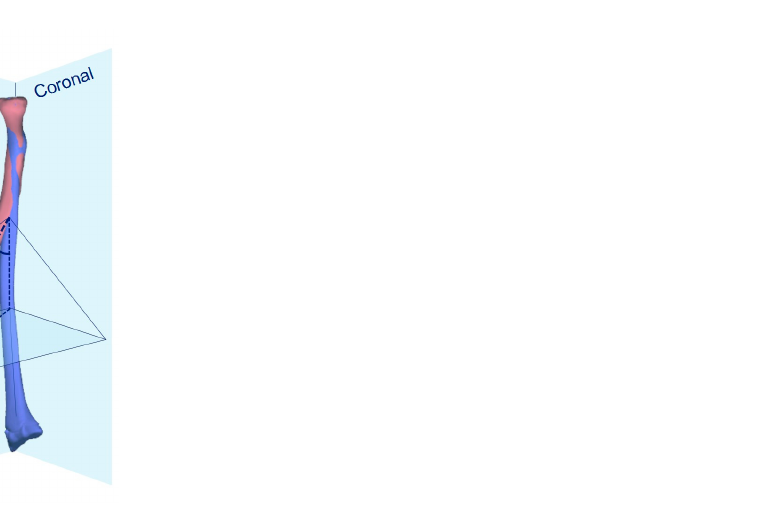
Figure 2. The maximal deformity angle (MDA) was calculated by combining the measurements of angular deformity in the coronal and sagittal plane according to the following formula: 𝑀𝐷𝐴 = (cid:3493)𝑡𝑎𝑛 (cid:2870) (cid:4666)𝐶𝑜𝑟𝑜𝑛𝑎𝑙(cid:4667) + 𝑡𝑎𝑛 (cid:2870) (cid:4666)𝑆𝑎𝑔𝑖𝑡𝑡𝑎𝑙(cid:4667)